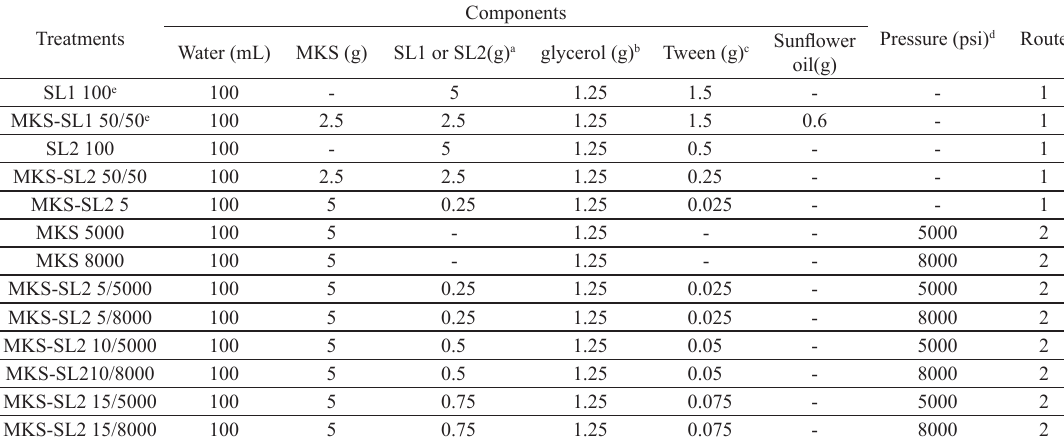
Table 2. Description of composition and conditions of treatment of the films.